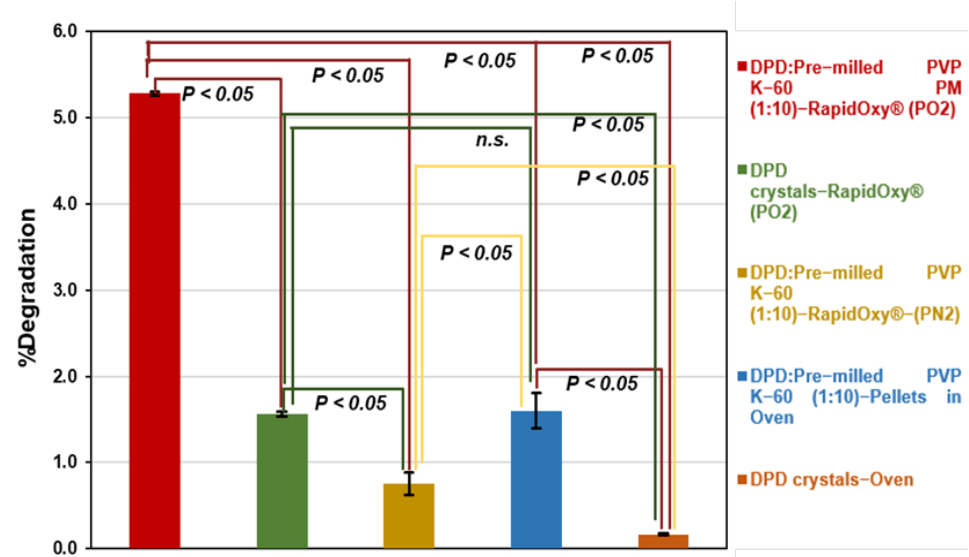
Figure 7. Evaluation of differences in oxidative degradation of DPD samples at 100 °C and 48 h conditions (green, yellow, blue, and orange bars indicate the degradation in control samples). Test of significance among degradation values is indicated by p − value ( p < 0.05 indicates the difference in degradation was statistically significant) whereas, n.s. indicates the p − value was not significant.